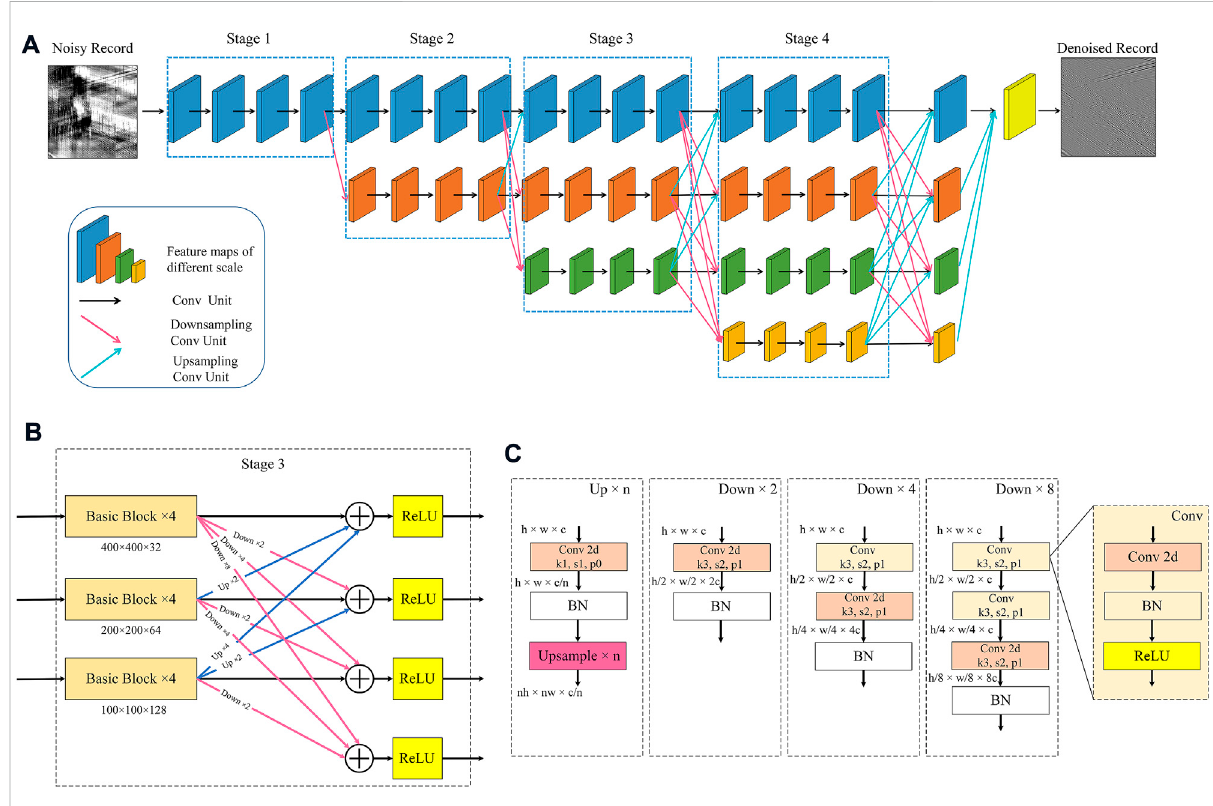
FIGURE 3 The architecture of the proposed network. (A) The architecture of MSI-Net. (B) The structure of a stage (Take the 3-th stage as an example) (C) Detailed structure of each part in Figure 3B.